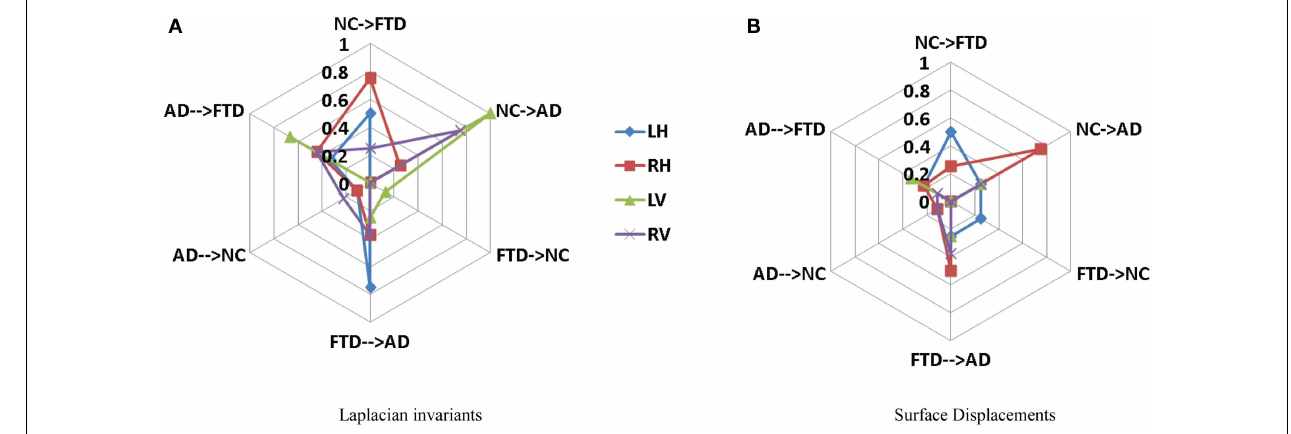
to the percentage of subjects who were originally AD but misclassified as FTD using a particular feature.The performances of each feature (e.g., Laplacian invariants) obtained from different structures are plotted in different colors indicated by the legend. Here, L, left; R, right; H, hippocampus; andV, ventricle. (A) Laplacian invariants, (B) surface displacements.